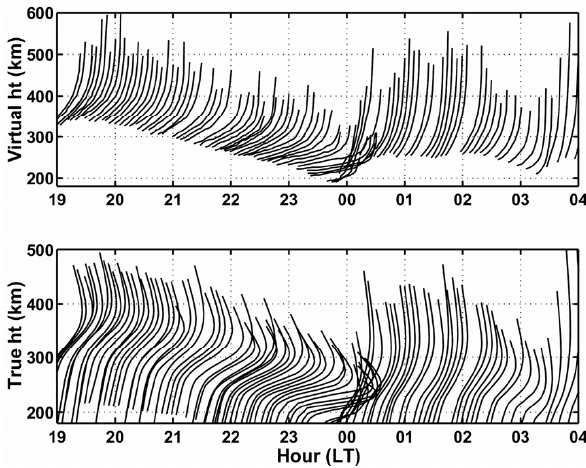
Fig. 4. Ionograms (upper) and the derived true height profiles given by POLAN (lower) measured on the night of 4 November 1997 and plotted as a function of time.